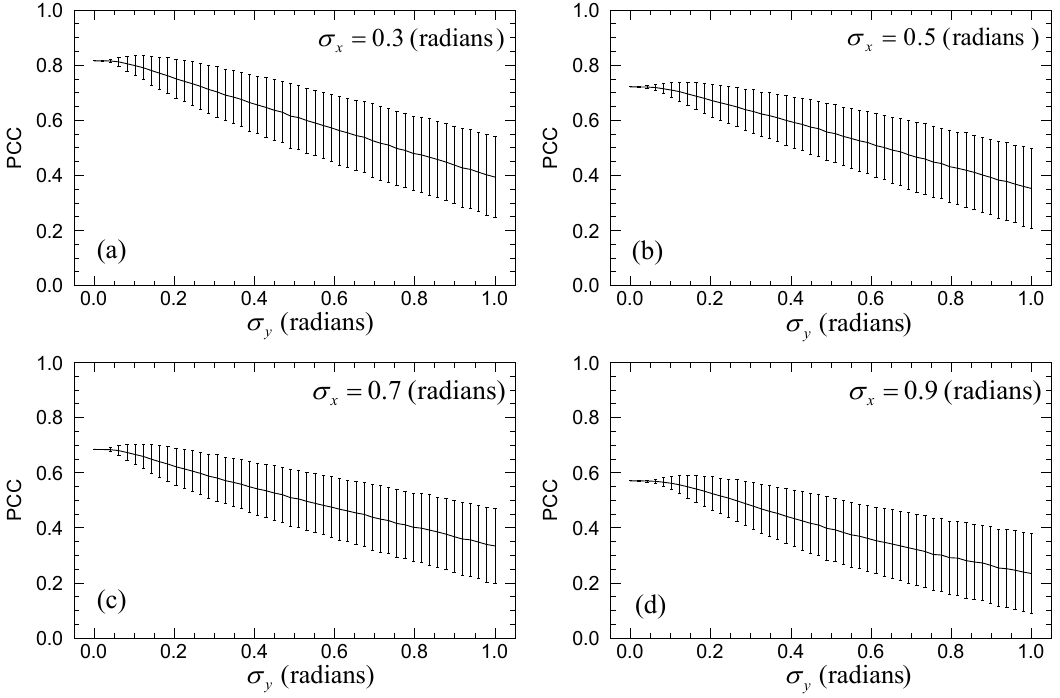
Figure 1. The variation of Pearson correlation coefficients (PCCs) represented as SDs in the simulated phase data at the two adjacent pixels. The solid curves depict the mean values of PCCs, while the error bars denote the SDs of PCCs. Noise SDs of the reference pixel’s phase values are 0.3, 0.5, 0.7, and 0.9 radians in ( a – d ),